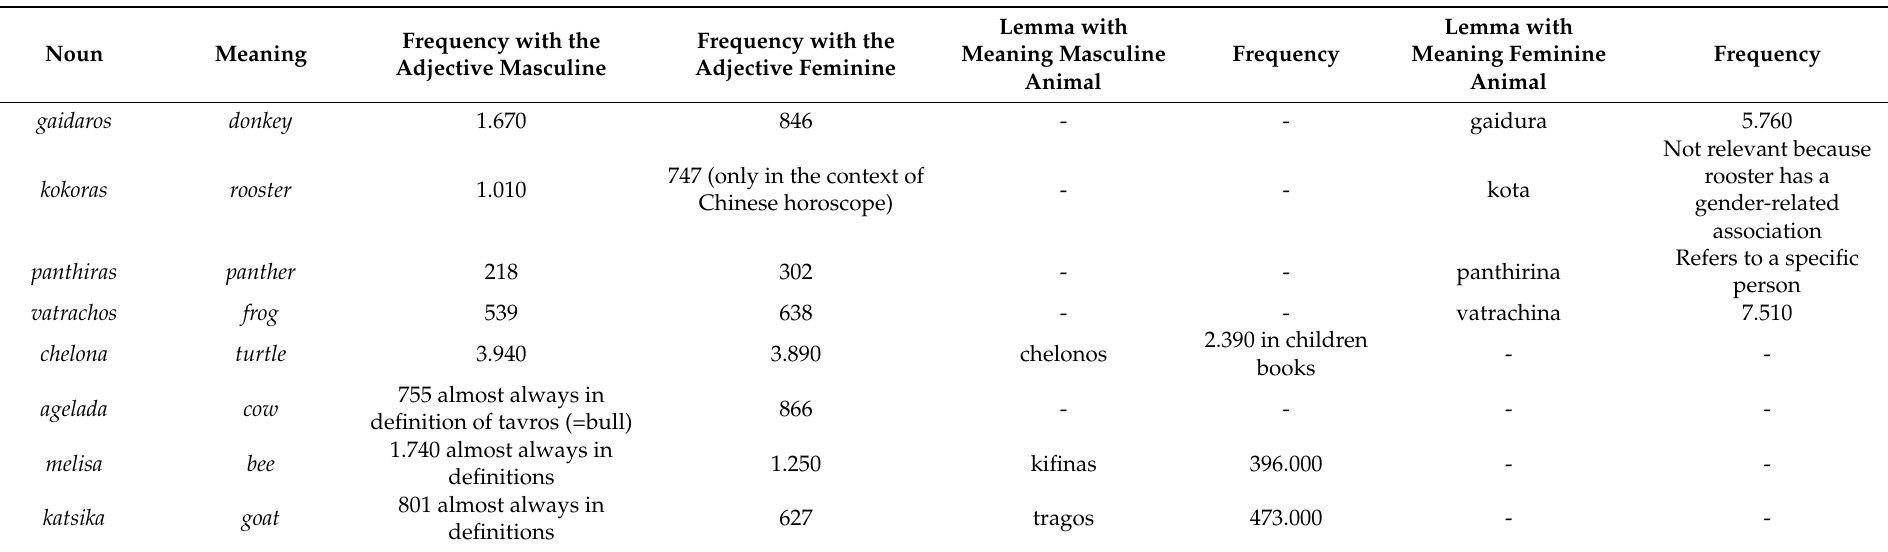
Table A1. Occurrences of the concordance of each feminine or masculine noun with the adjective arsenikos (=masculine) and thilikos (=feminine) and the frequency of a separate lemma denoting the feminine animal for the masculine nouns or the masculine animal for the feminine nouns along with its